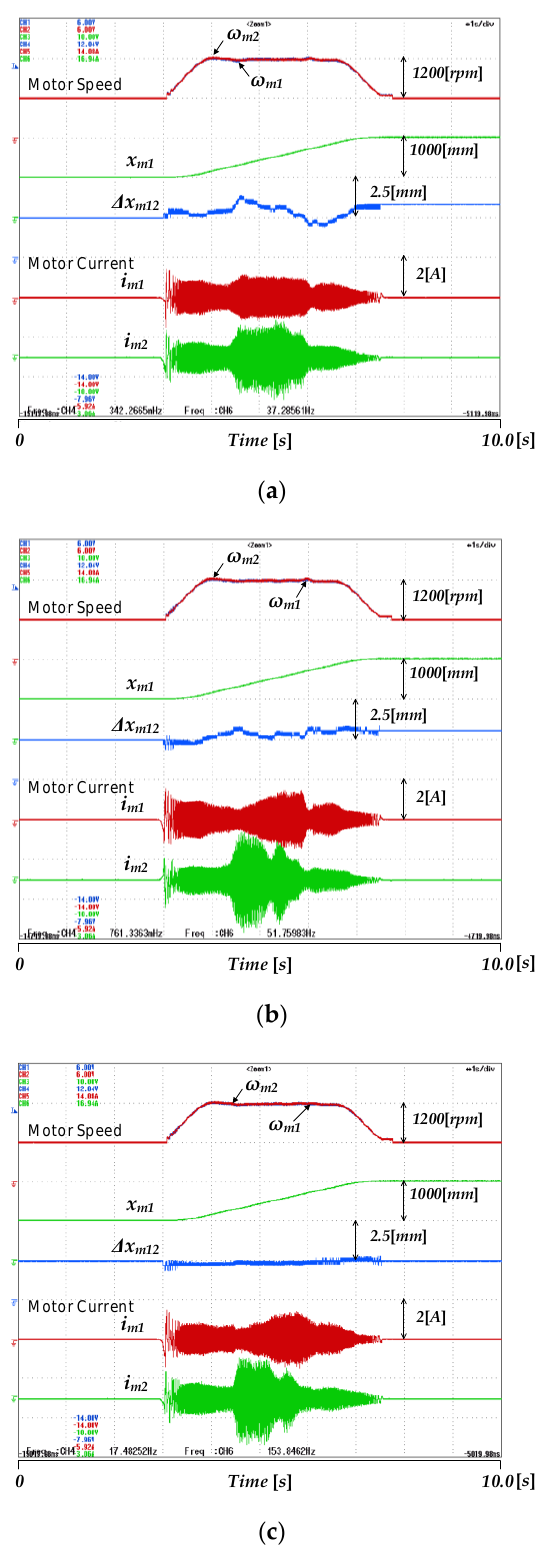
Figure 13. Experimental result of 10N continuous load on the right motor: ( a ) conventional position control method; ( b ) balancing position control method; ( c ) proposed control method.